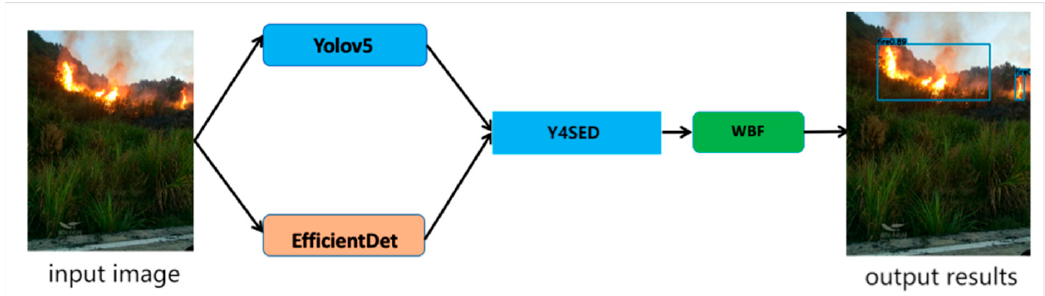
Figure 4. Integration model architecture diagram.